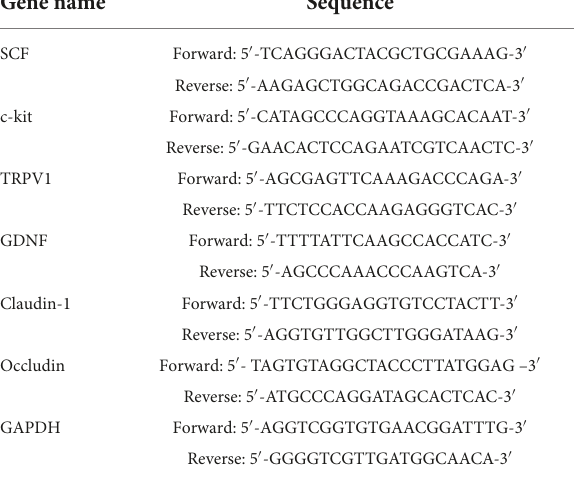
TABLE 1 Primer sequences used in this